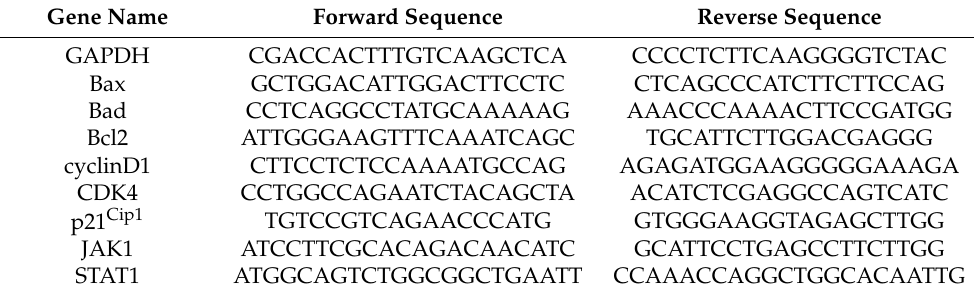
Table 1. List of forward and reverse sequences of primers used during qRT-PCR